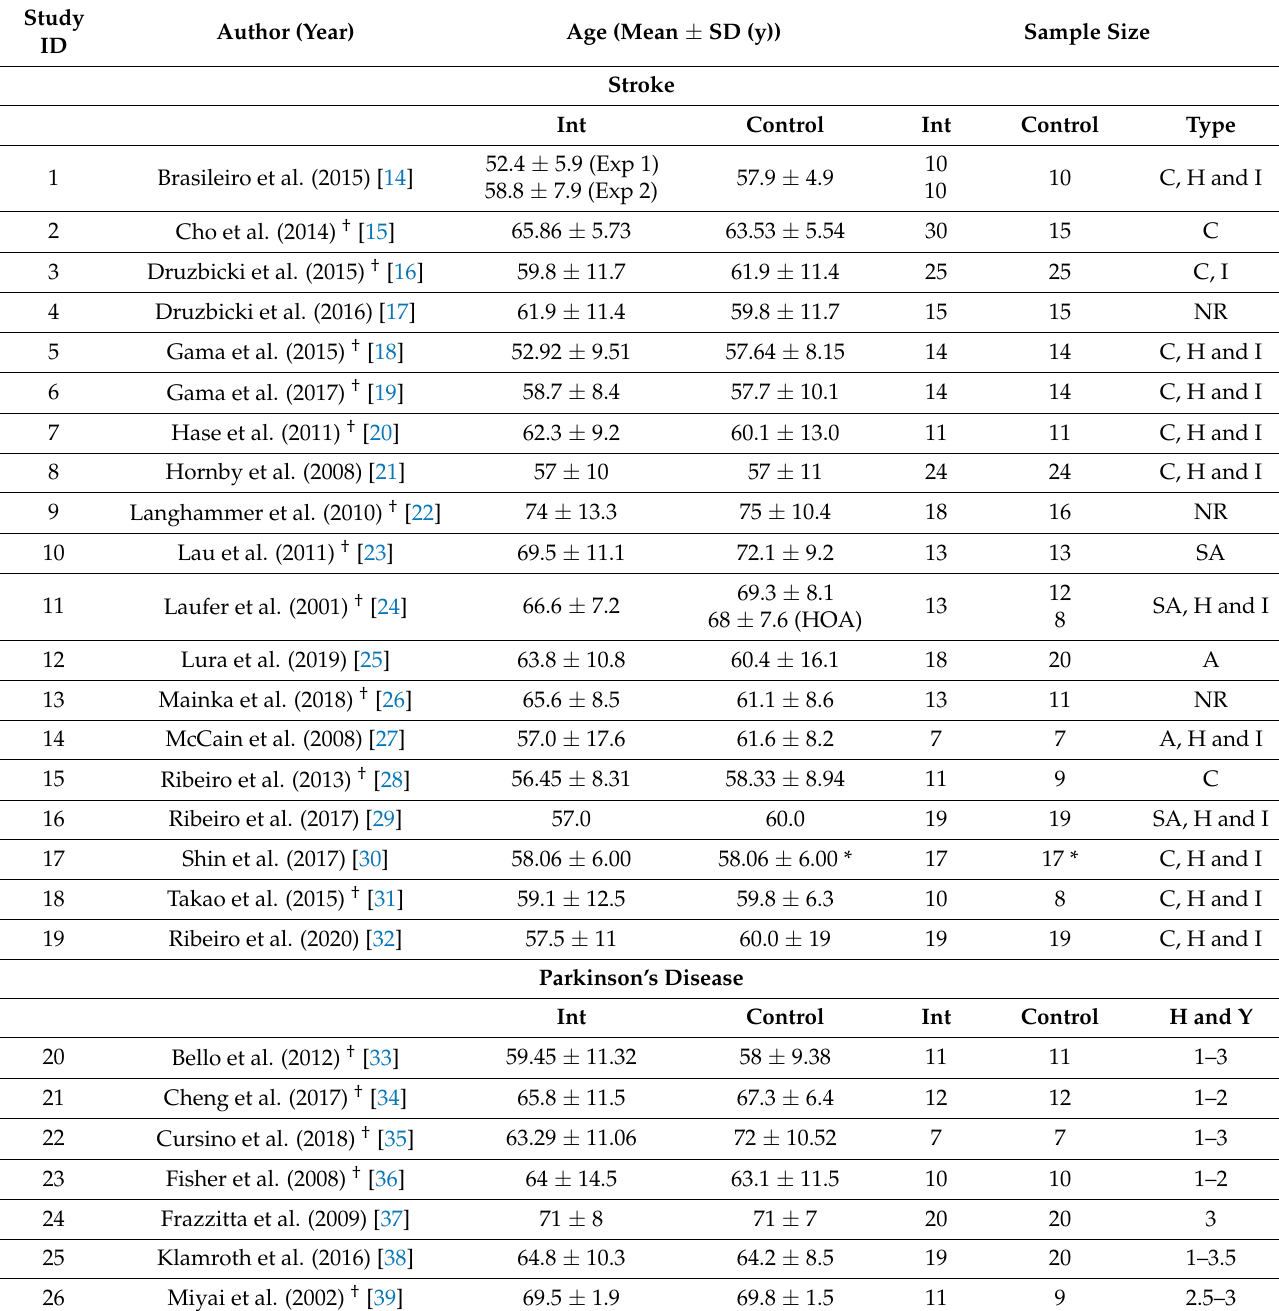
Table 1. Study and participant